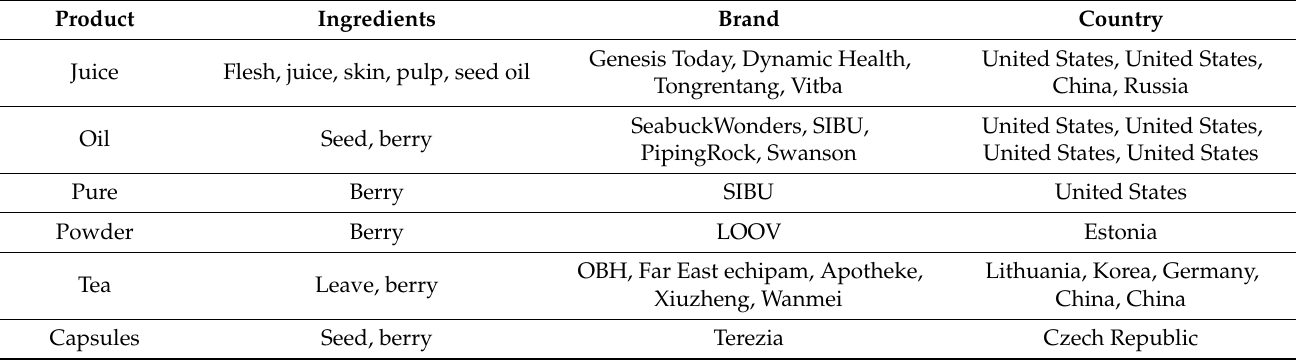
Table 4. Selected examples of marketed Hippophae rhamnoides